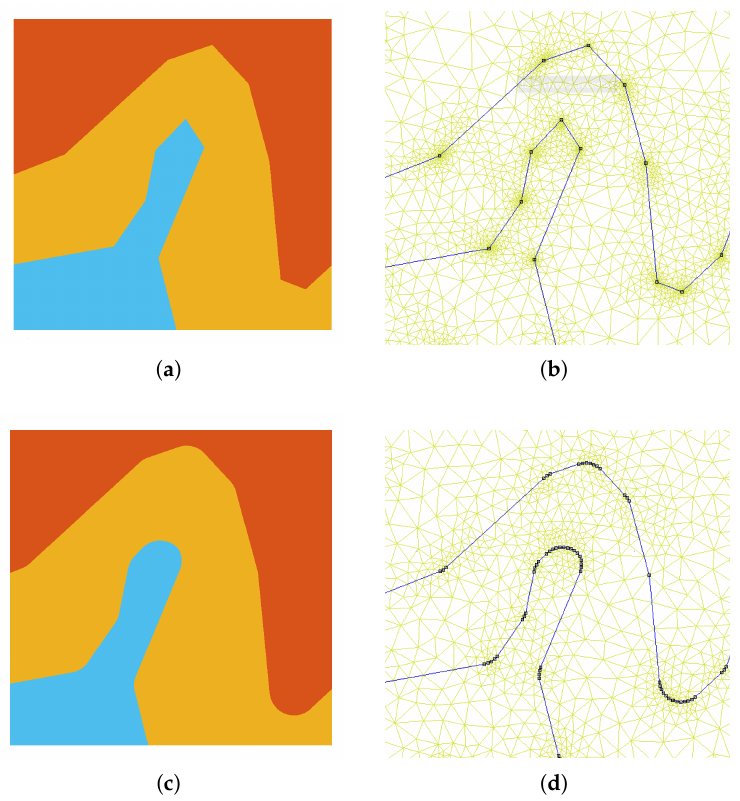
Figure 5. Manual control of the tetrahedral mesh: the boundaries were smoothed to avoid singulari- ties. Tissue boundaries before local smooth edits ( a ) and the related mesh ( b ). Tissue boundaries after local smooth edits ( c ) and the related mesh ( d